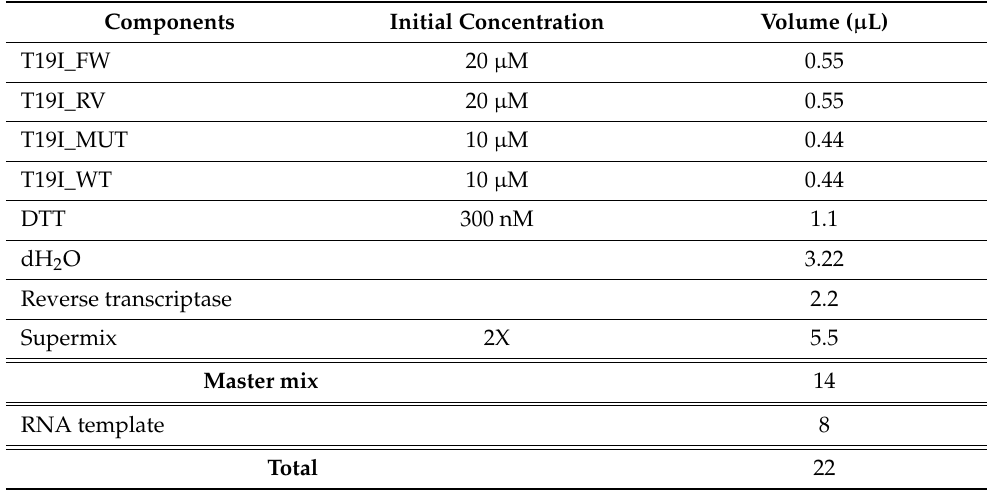
Table 2. Composition of the mixture for the RT-ddPCR